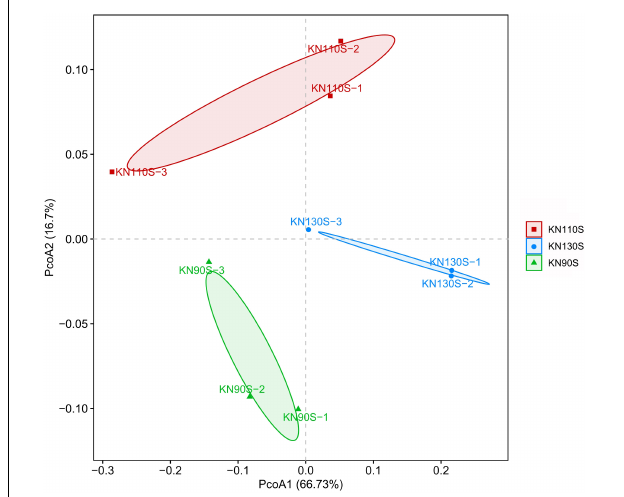
FIGURE 2 | Principal coordinates analysis (PCoA) of the bacterial community for king grass silages (KN90S, king grass silage harvested at growth periods of 90 days; KN110S, king grass silage harvested at growth periods of 110 days; KN130S, king grass silage harvested at growth periods of 130 days).